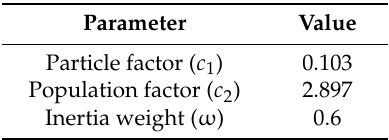
Table 1. Parameters for PSO.